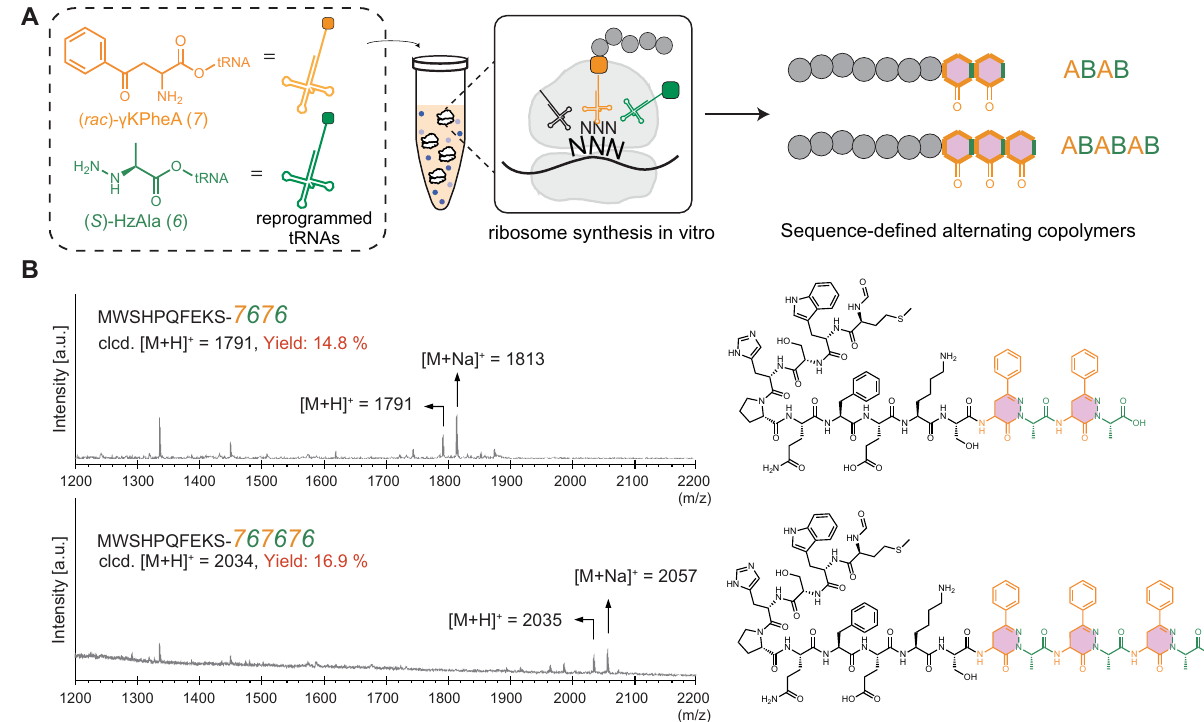
Fig. 4 | Ribosomal synthesis of alternating copolymers with a pyridazinone backbone. A We designed an additional amino acid, γ KPheA ( 7 ), bearing a ketone on its γ -carbon of the sidechain, for sequential polymerization of pyridazinones bondsonabiopolymerchain.Compounds 7 and 6 werechargedtotRNA Pro1E2 (GGU) and tRNA GluE2 (GAU) by fl exizyme, respectively, and added to an in vitro transcrip- tion and translation reaction. The genetic template was designed to consecutively incorporate the monomers in an alternating fashion (ABAB- or ABABAB-type). The